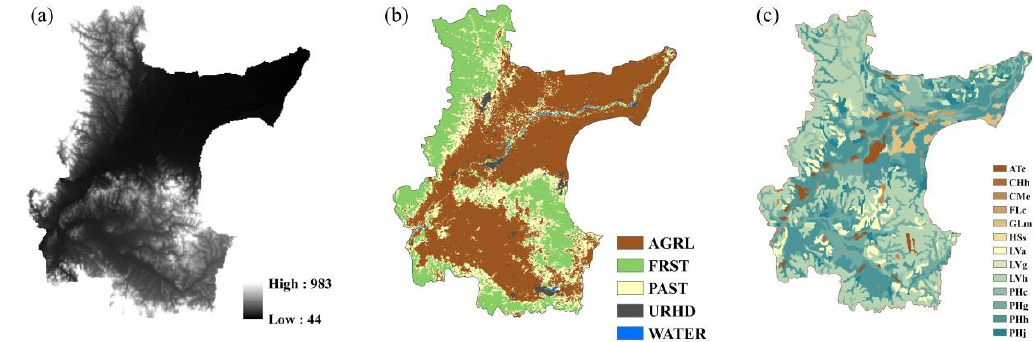
Figure 3. Soil and Water Assessment Tool (SWAT) model database of study area. ( a ) Digital elevation model (DEM), ( b ) land-use, ( c ) soil.